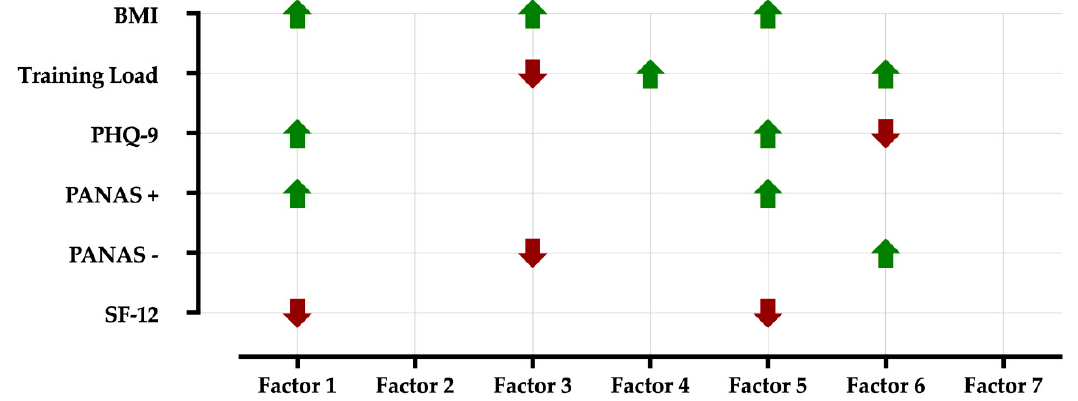
Figure 4. Interactions between Factors (dependent variables) and Body Mass Index (BMI), training load, and psychometric scales (PHQ-9, PANAS + , PANAS − , and SF-12). Green arrows show positive correlations, while red arrows negative correlations. Only significant interactions have been reported ( p < 0.05).